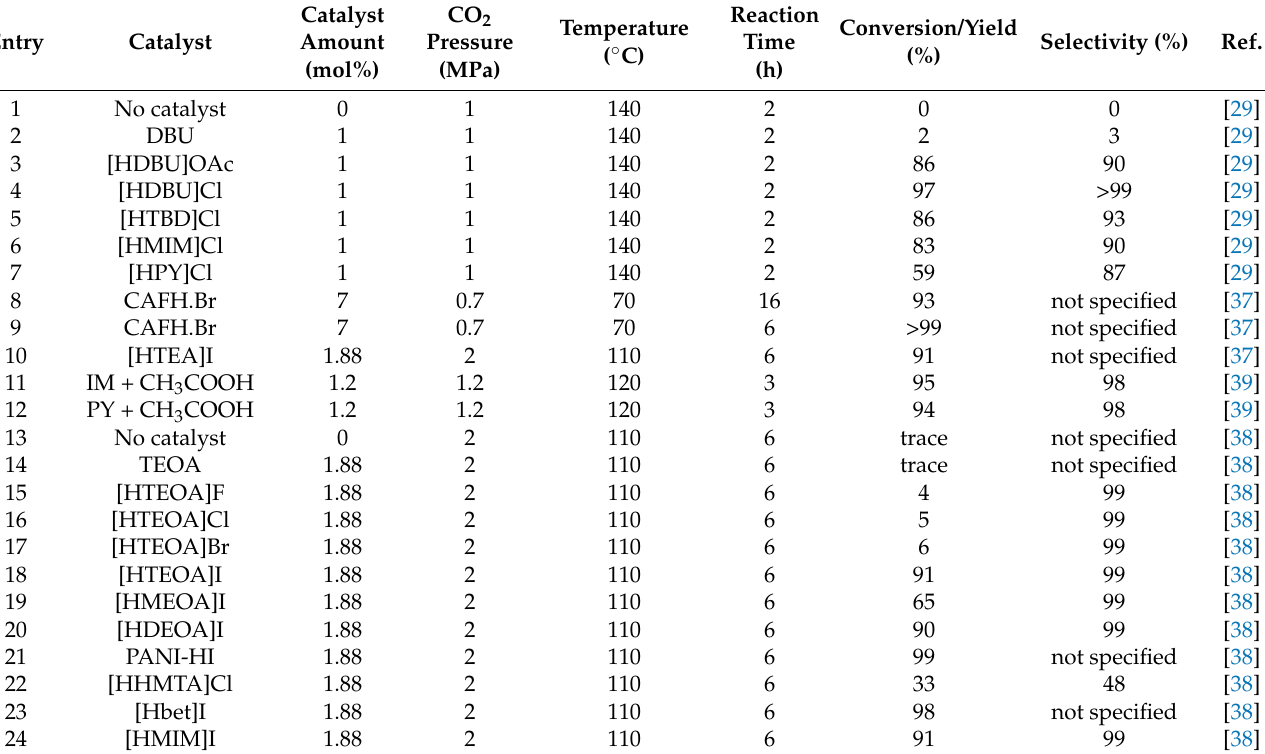
Table 3. Comparison of the catalytic effects of amines and their salts on the carbonation of PO.